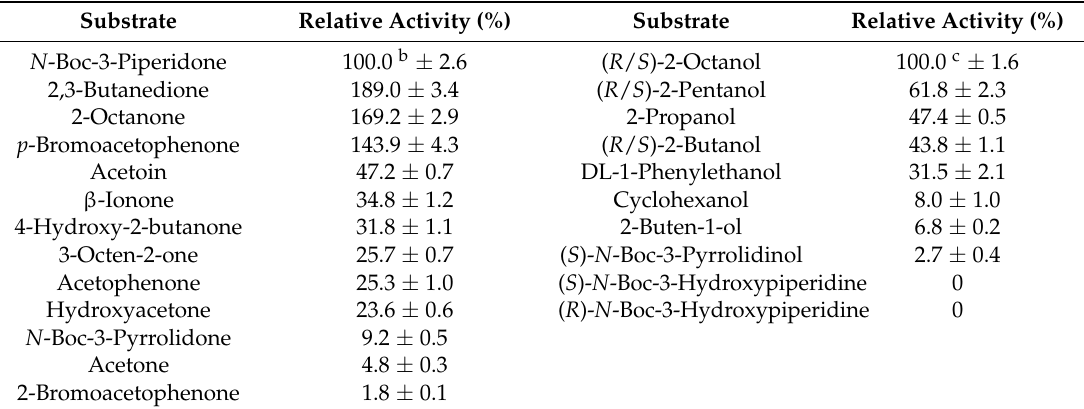
Table 1. Substrate spectrum of recombinant ReCR against ketones and alcohols a .